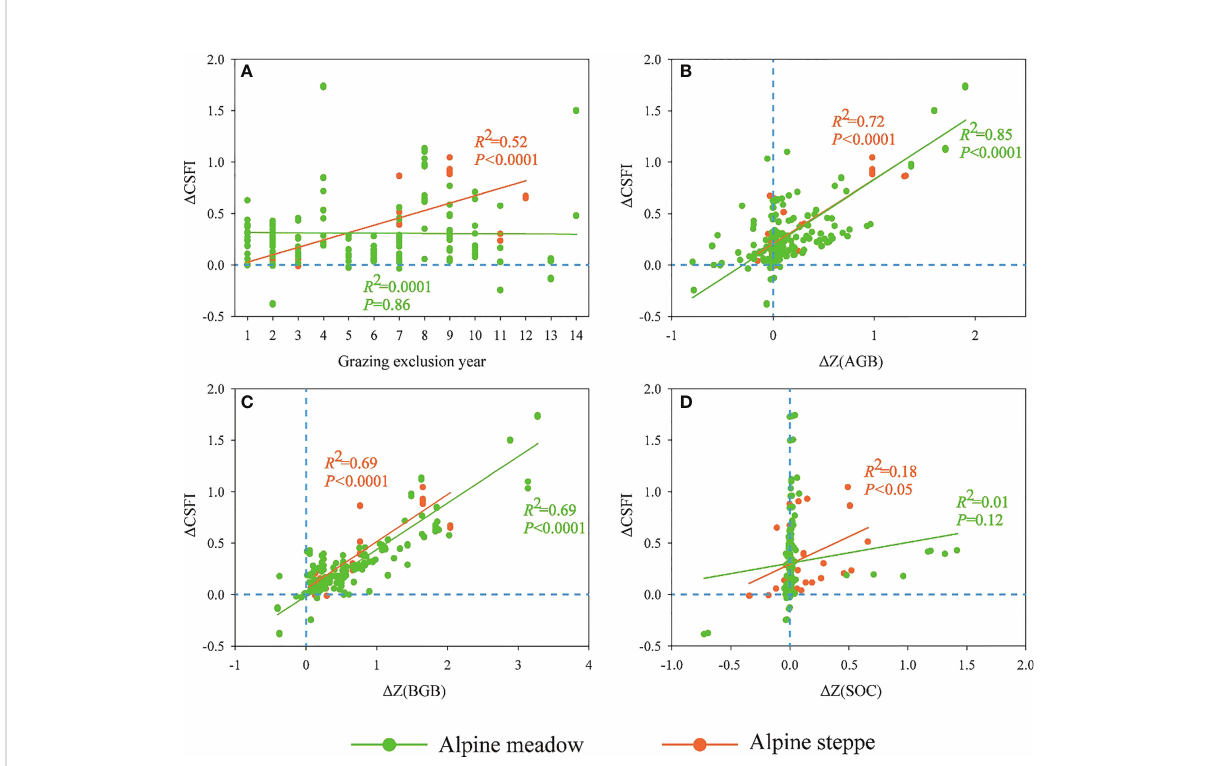
FIGURE 5 The relationships between D CSFI and (A) the duration of grazing exclusion (GE), (B) D Z(AGB), (C) D Z(BGB), and (D) D Z(SOC). The CSFI, AGB, BGB and SOC represent the composite index of carbon stock function, aboveground biomass, belowground biomass and soil organic carbon,